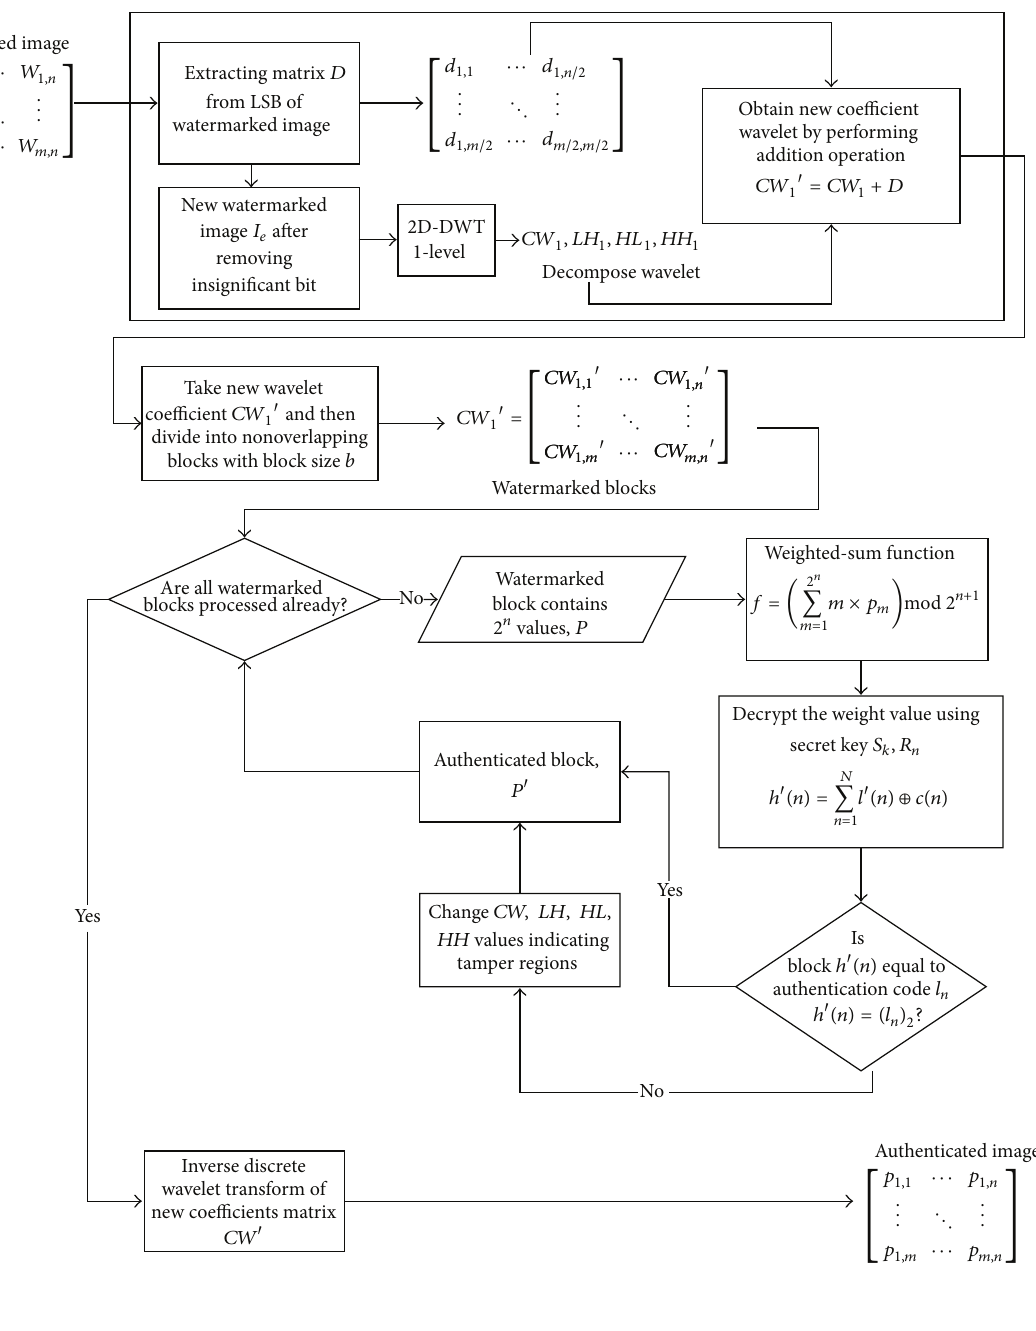
Figure 2: Diagram of the proposed authentication